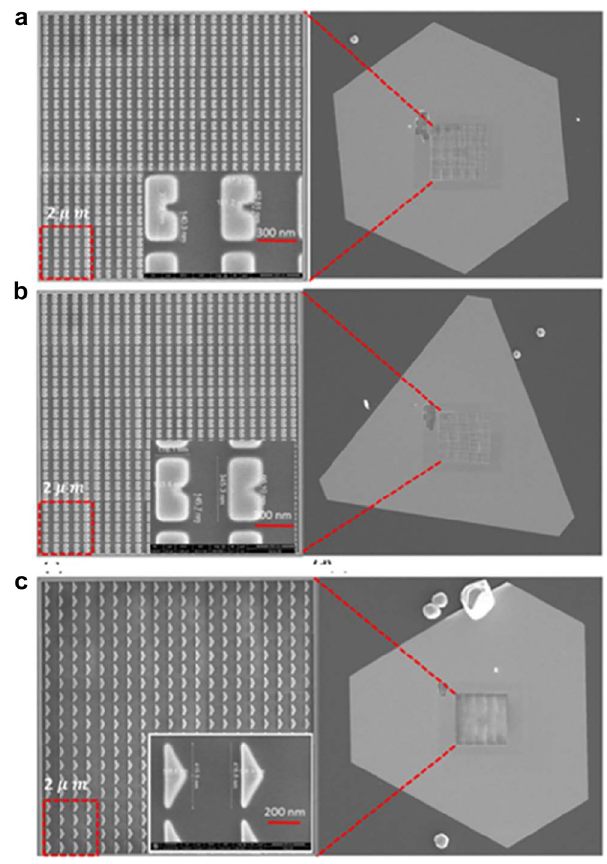
Figure 2: The single crystalline Au flake that is grown chemically on a quartz substrate, the zoomed area is showing the quality of the nanostructure fabrication on it. The nanostructure with area of 10 × 10 μ m 2 is showing 25 sections of the four steps fabrication, each having an area of 2 × 2 μ m 2 , as shown with the square shape with red broken lines. (a) SRR Au-DRM. (b) Heptagonal Au-DRM. (c) Triangular